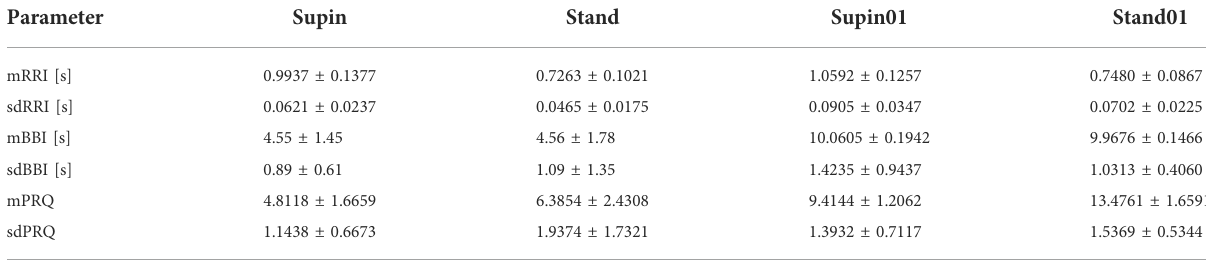
TABLE 1 RRI, BBI and PRQ (mean ± SD) for 20 healthy subjects in four physiological states; Supin — supine position with spontaneous breathing, Stand — standing with spontaneous breathing, Supin01 — supine position with slow (0.1 Hz) breathing, Stand01 — standing with slow (0.1 Hz) breathing (adopted from Mati ć et al., 2020 and completed by PRQ data for comprehensive analysis).